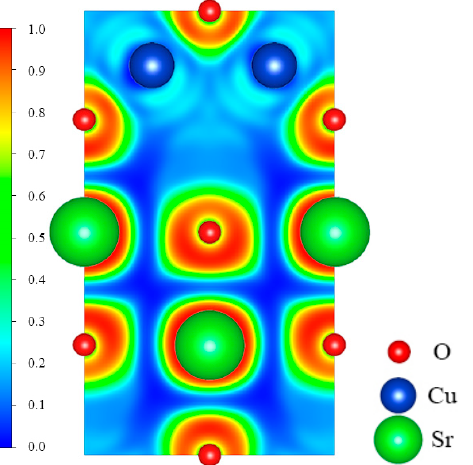
Figure 4. Calculated electron localization function (ELF) for the (010) plane across Sr, Cu, and O